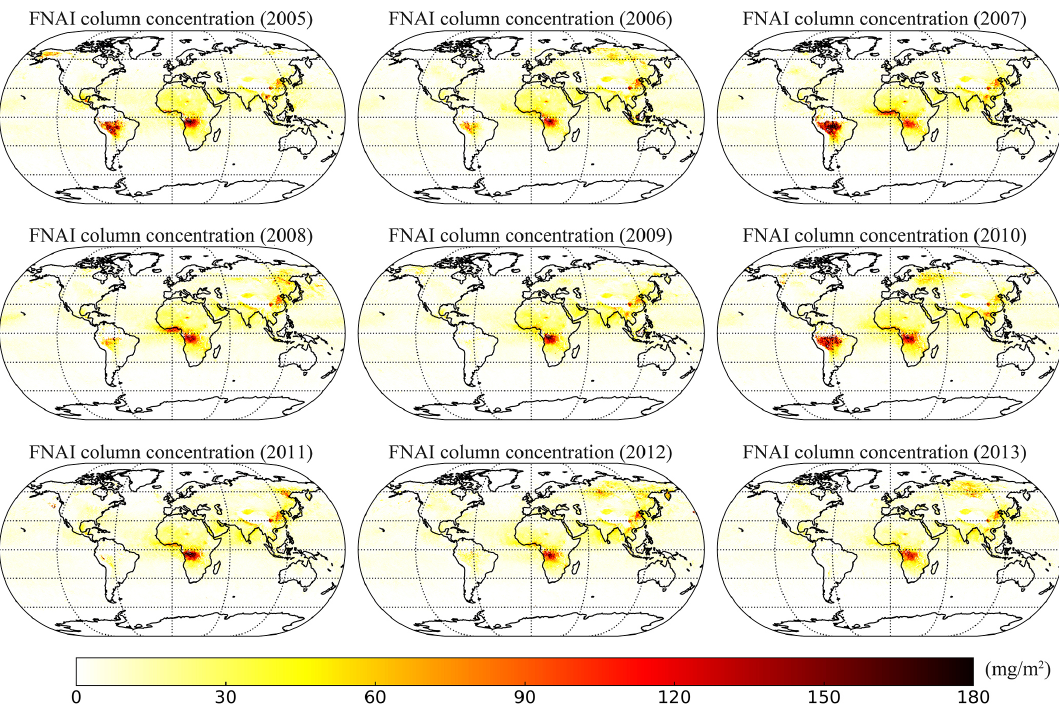
Figure 16. Yearly mean of FNAI column mass concentration (mgm − 2 ) derived from POLDER-3 observations using the GRASP/Component approach for the period from March 2005 to October